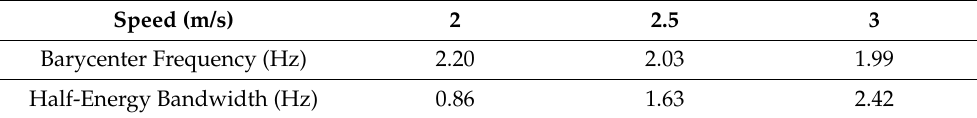
Figure 13. The magnetic field time domain and power spectrum of the submarine passing through monitoring point A at different speeds. ( a ) Time domain and ( b ) power spectrum. Table 3. Barycenter frequency and half-energy bandwidth of the wake magnetic field at different speeds.